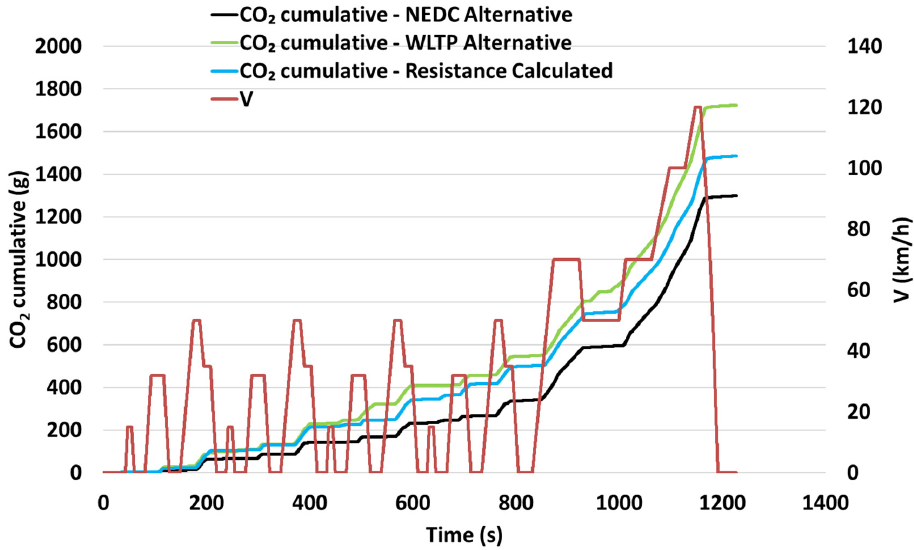
Figure 5. Comparison of variations in cumulative CO 2 emissions for the analysed